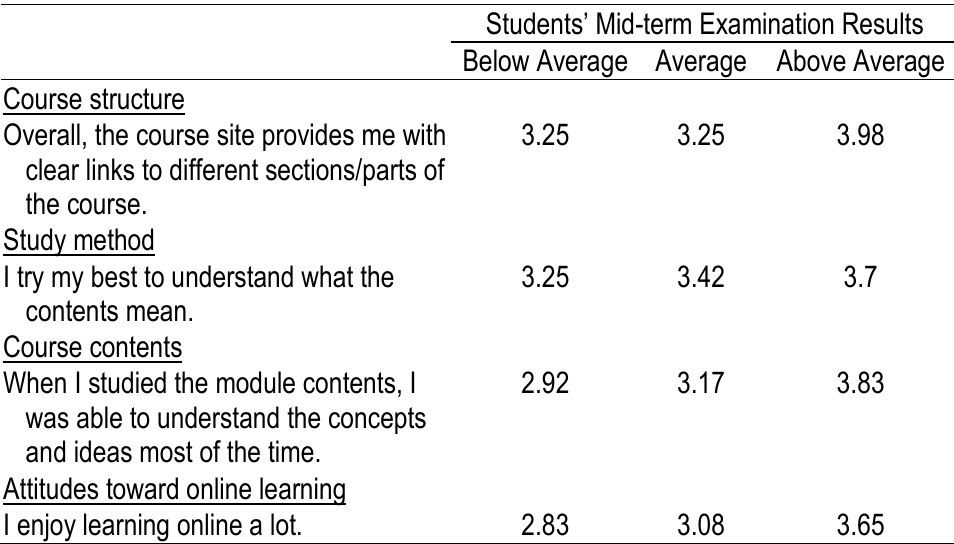
Table 7. Comparing findings among students of different mid-term results Students’ Mid-term Examination Results Below Average Average Above